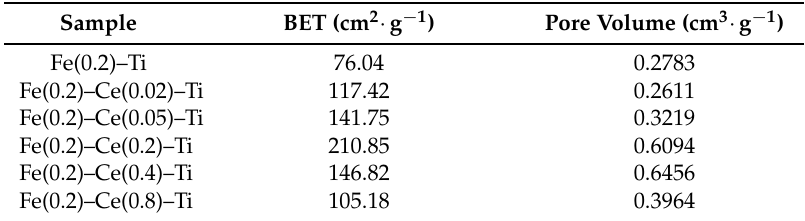
Table 1. Physical properties of various catalysts.